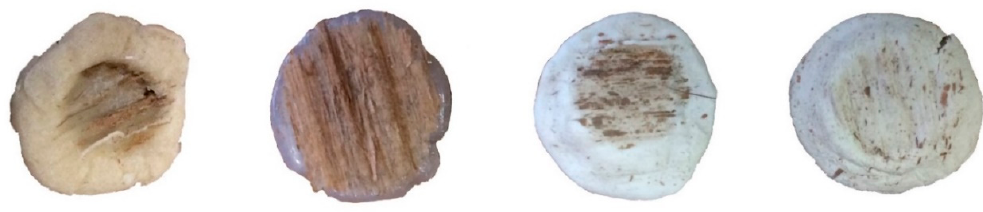
Figure 3. From left to right: Wheat flour, ethylene-vinyl acetate copolymer (EVA), calcium carbonate, aluminosilicate.